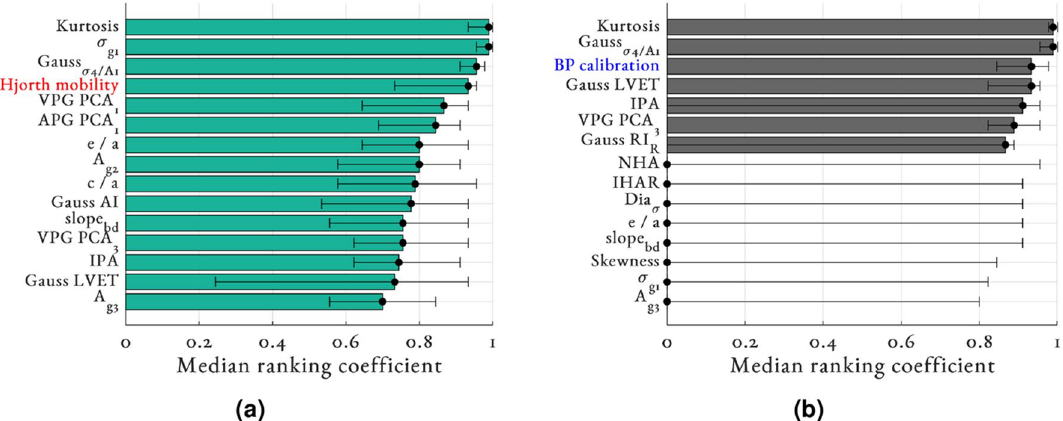
Figure 5. Median SHAP values feature ranking coefficient for ( a ) random forest and ( b ) LASSO+OLS both with PPG + ECG feature set. Features are ordered by their respective median ranking coefficient. Error bars denote the range. Demographic features are highlighted in blue and ECG features in red for clarity. For brevity, only the top 15 features are provided here with the full list provided in Supplementary Information figure SI